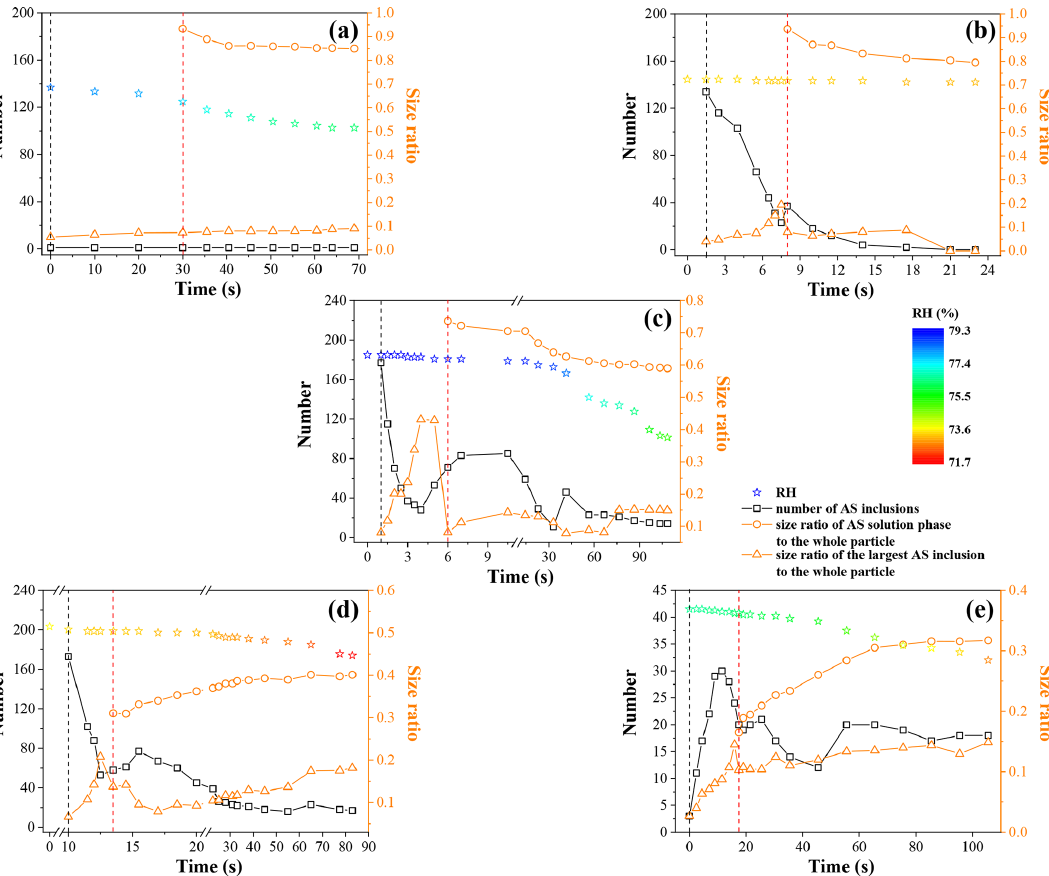
Figure 8. Temporal changes in number of AS inclusions, size ratios of AS solution phases and the largest AS inclusions to the whole particles, as well as the corresponding RH during LLPS for mixed 1, 2, 6-hexanetriol / AS particles with OIR = 1 : 4 (a) , 1 : 2 (b) , 1 : 1 (c) , 2 : 1 (d) and 4 : 1 (e) . The black dashed line corresponds to the appearance of AS inclusions. The red dashed line corresponds to the appearance of the AS solution